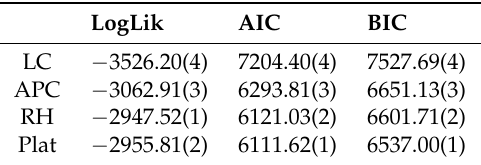
Table 3. Models comparison for UK females.